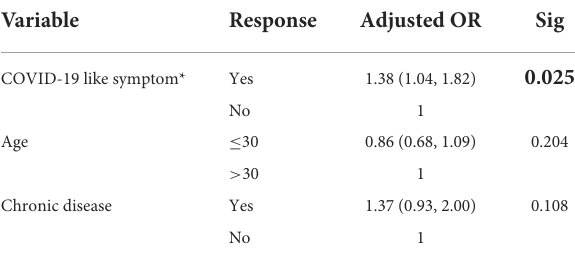
TABLE 14 Binary logistic regression model, the association between COVID-19 like symptom and systemic side effect among healthcare workers in Ethiopia,